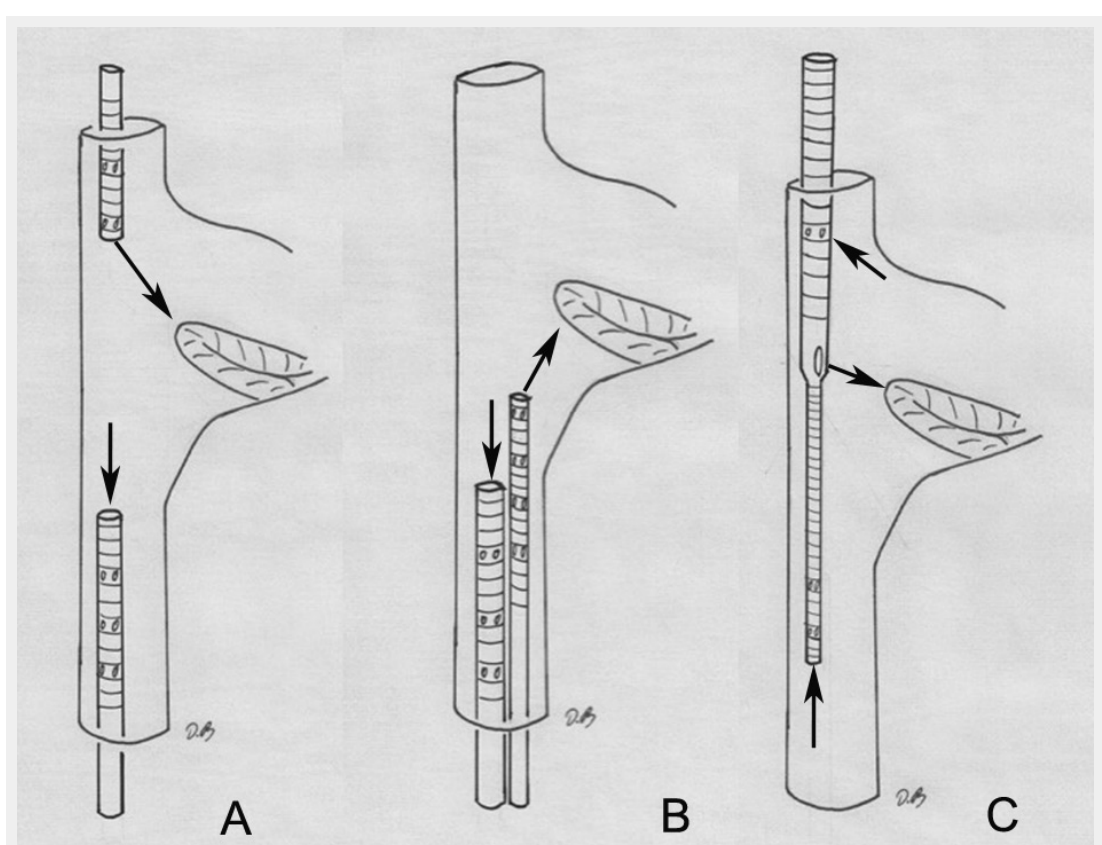
Configuration of the venovenous extracorpareal life support cannulation. (A) Femoroatrial cannulation, where the cannula positioned in the femoral vein serves as a drainage device and is placed with its tip 5 to 10 cm inferior to the angle between the inferior vena cava and right atrium. The oxygenated blood is returned via a cannula positioned in the internal jugular vein. (B) Femorofemoral cannulation. The drainage cannula is positioned with its tip about 5 to 10 cm below the junction between the inferior vena cava and right atrium. The oxygenated blood is delivered by the other cannula that has its tip positioned in the right atrium. (C) Single venovenous cannulation, here the drainage segments are positioned in the superior and inferior vena cava. The oxygenated blood is delivered in the right atrium just in front of the tricuspid